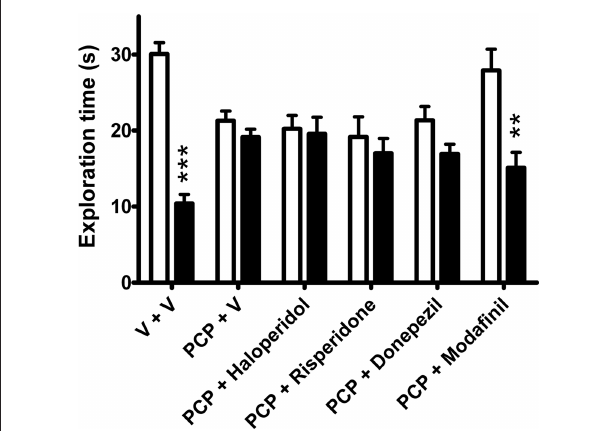
Figure 2 | The effects of vehicle ( n = 31), haloperidol (0.1 mg/kg, n = 9), risperidone (0.2 mg/kg, n = 12), donepezil (3 mg/kg, n = 12), and modafinil (64 mg/kg, n = 10) on exploration time (s) of a novel (open bars) and familiar (closed bars) object in the NOr task in rats sub- chronically treated with PCP ( n = 33). Data expressed as mean + SEM. *** P < 0.001, ** P < 0.01 versus novel object exploration (one-way ANOVA followed by Bonferroni’s multiple comparison post hoc analysis).